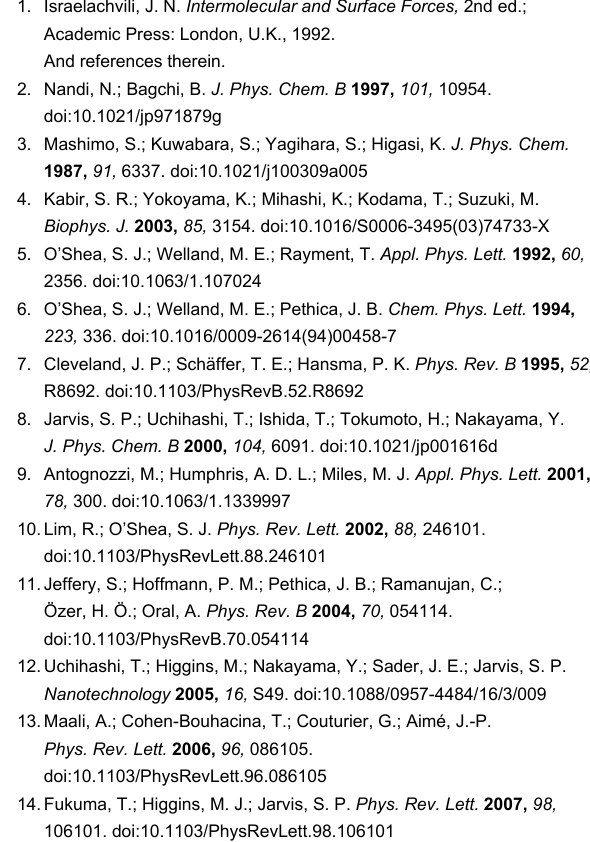
Figure 7: Derivation of the viscoelasticity of hydrated water. The compliance data shown in Figure 6 are inverted to give the elasticity (a). Solid and broken lines indicate the real and imaginary parts, res- pectively, and fine and thick lines the data at 300 nm and in close prox- imity, respectively. Subtraction of the two data sets gives the real (solid line) and imaginary (broken line) parts of the viscoelasticity